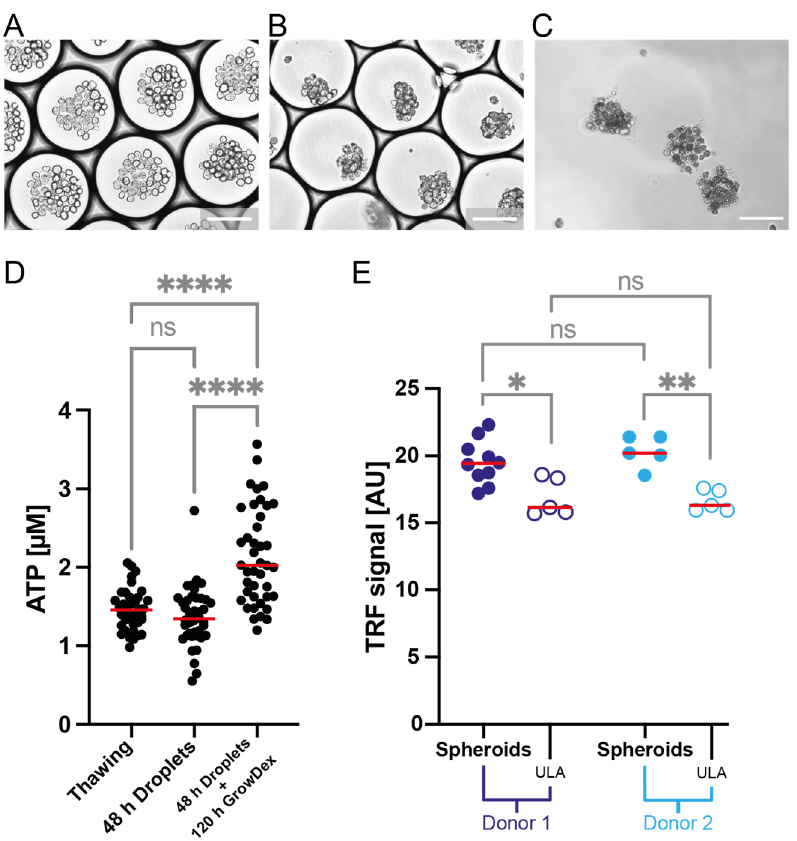
Figure 8. The microfluidic droplet format supports functional cell spheroid formation from primary cells. ( A – C ) show representative brightfield images of primary cell spheroid formation using microfluidic droplets generated with the minimal droplet generation setup. White scale bars indicate 100 µm. ( A ) shows the emulsion directly after encapsulation of primary hepatocytes. ( B ) is an image of the emulsion after 24 h of incubation in a syringe, at 37 °C, 5% CO 2 , and 100% humidity. ( C ) shows the spheroids after breaking of the emulsion after 24 h of incubation, demonstrating cohesiveness of the cell assemblies. ( D ) Plot showing ATP concentration as a proxy for viability. Viability of the cells is maintained between thawing and 48-h droplet incubation and breaking of the emulsion. After another 120-h incubation in GrowDex, the viability, as measured by ATP concentration, increases, indicating proliferation. ( E ) compares the functionality of primary hepatocyte spheroids formed in microfluidic droplets encapsulated with the minimal droplet generation setup and spheroids formed in ULA plates from two different sample donors using an albumin quantification assay. Both samples were assessed after 7 days (droplet spheroids were inicubated for 48 h in droplets + 120 h in GrowDex; ULA sample were inicubated for 168 h in ULA plates). In both examined cases, albumin secretion appears to be higher in spheroids assembled in microfluidic droplets. The four stars indicate a p -value of <0.001, two stars a p -value of <0.01, one star a p -value of <0.05, ns indicates insignificance (analyzed with a one-way ANOVA).